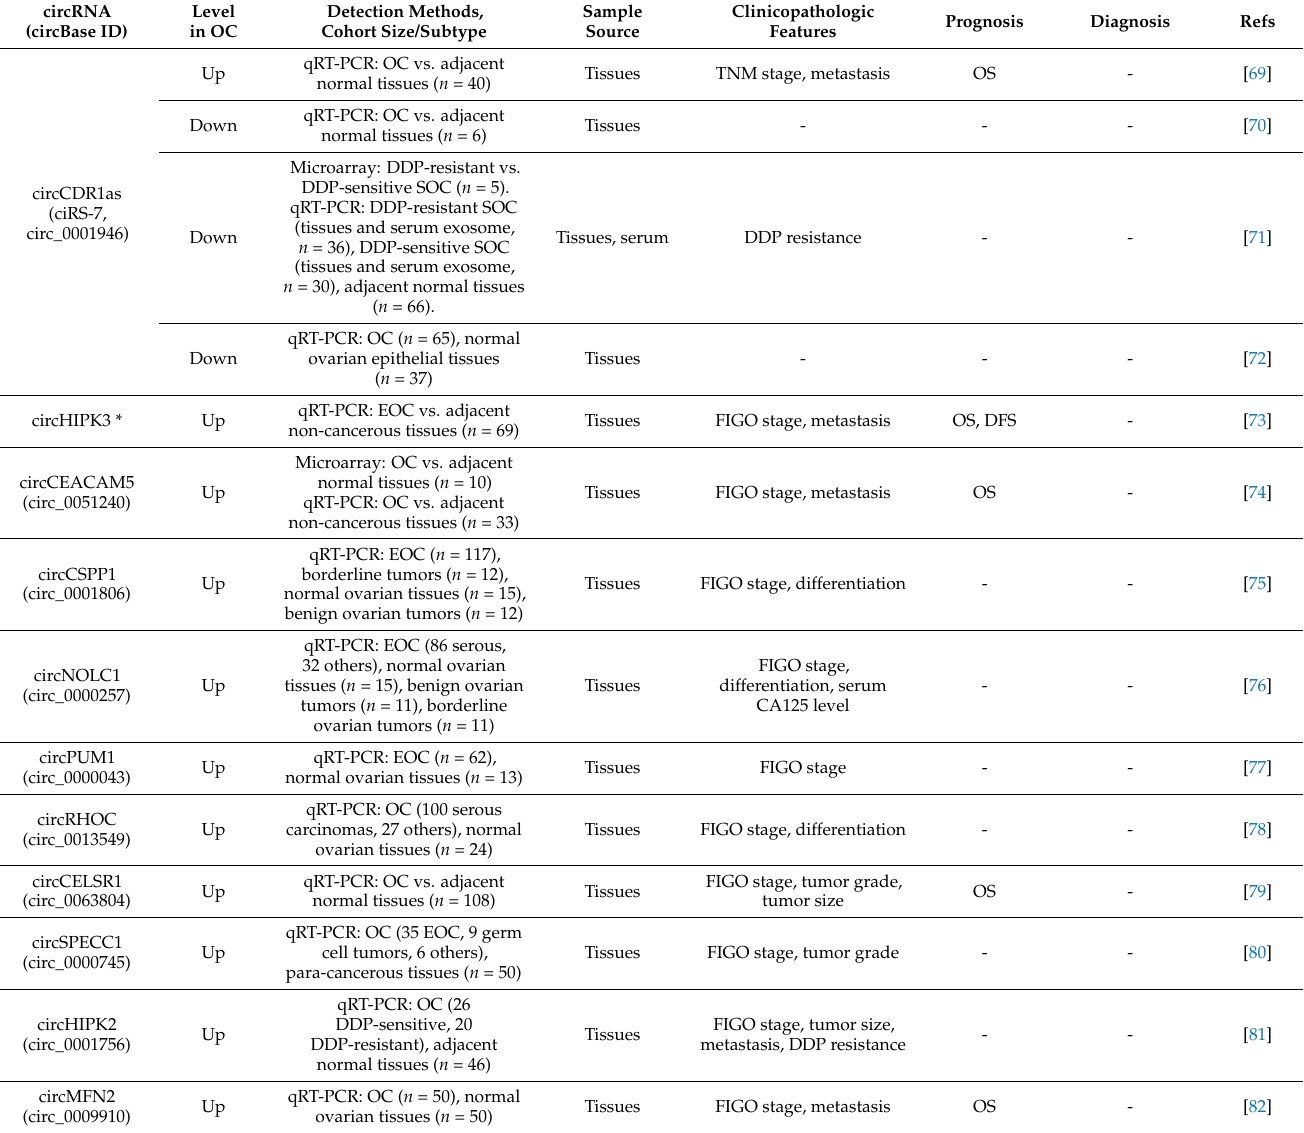
Table 1. Dysregulated circRNAs in OC and their potential as biomarkers.